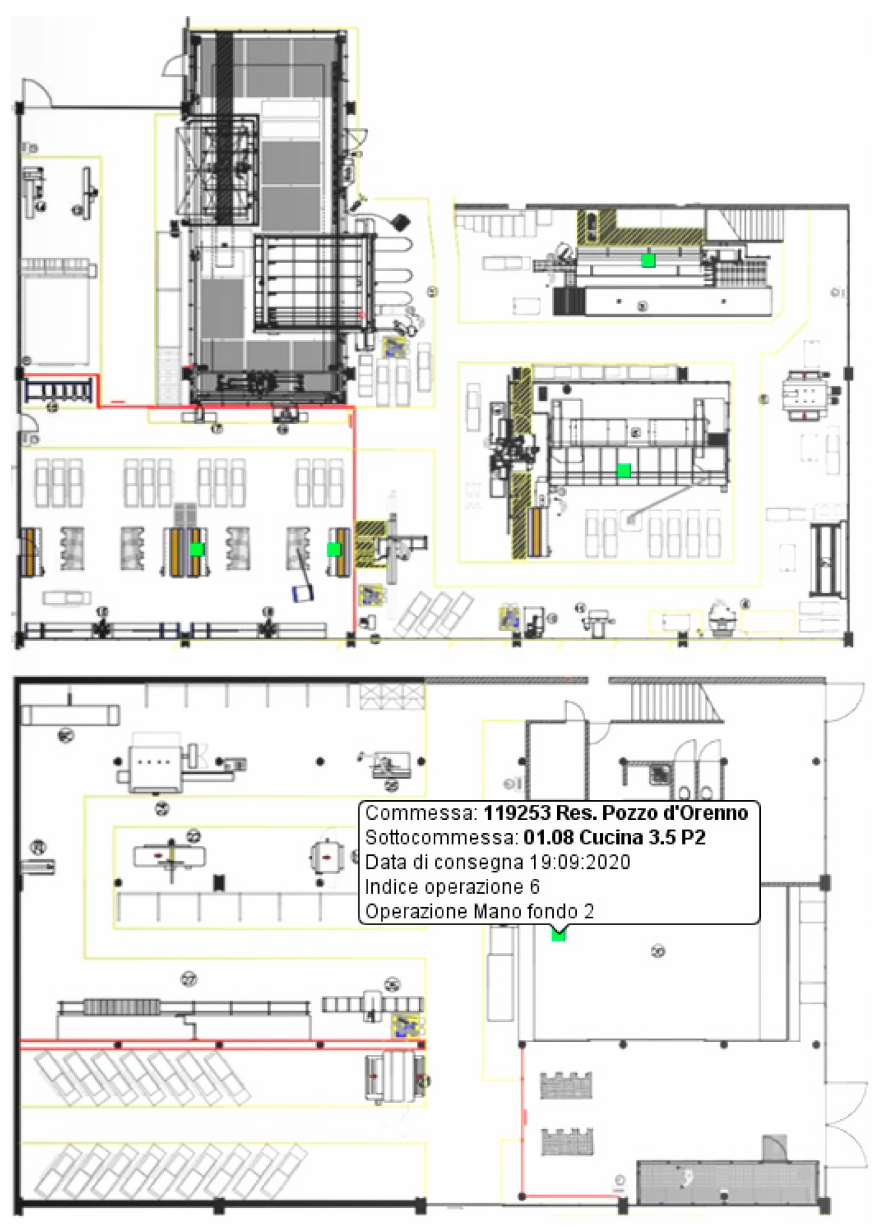
Figure 4. Identified layout of the production